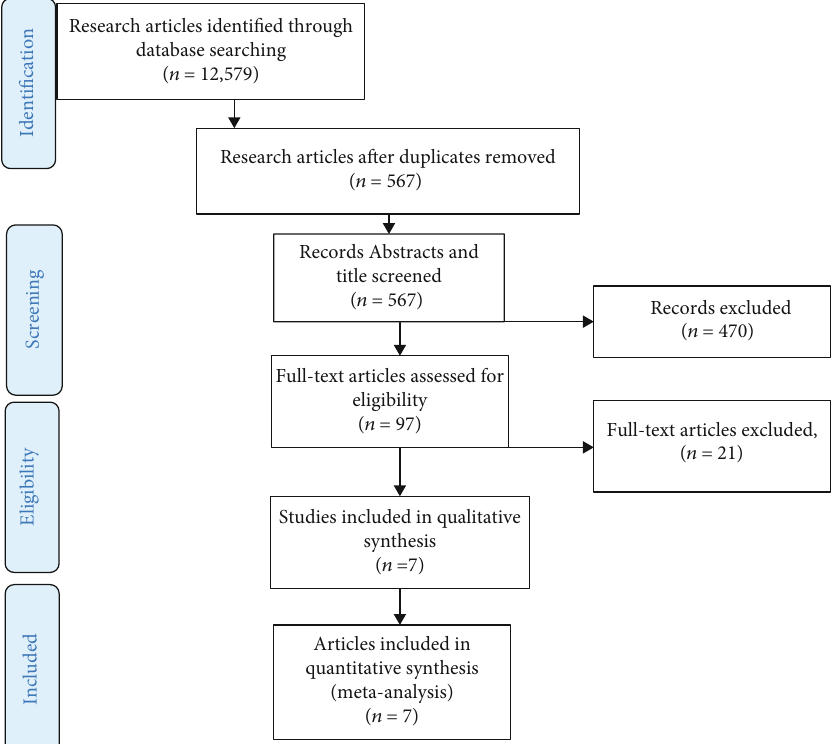
Figure 1: The fl ow diagram refers to the selection of studies included for a systematic review and meta-analysis of the prevalence of malaria among